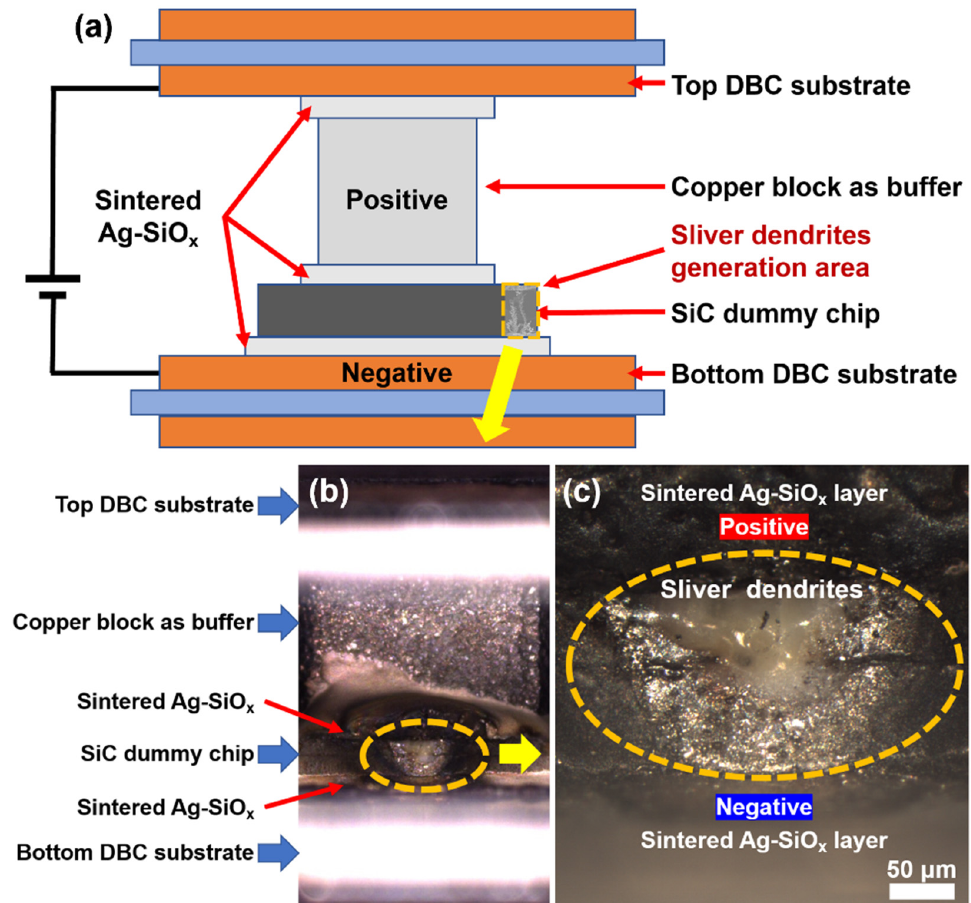
Figure 5. ( a ) Schematic diagram of DSC device, ( b ) metallographic micrograph of the DSC device after ECM failure, and ( c ) the corresponding magnified image.